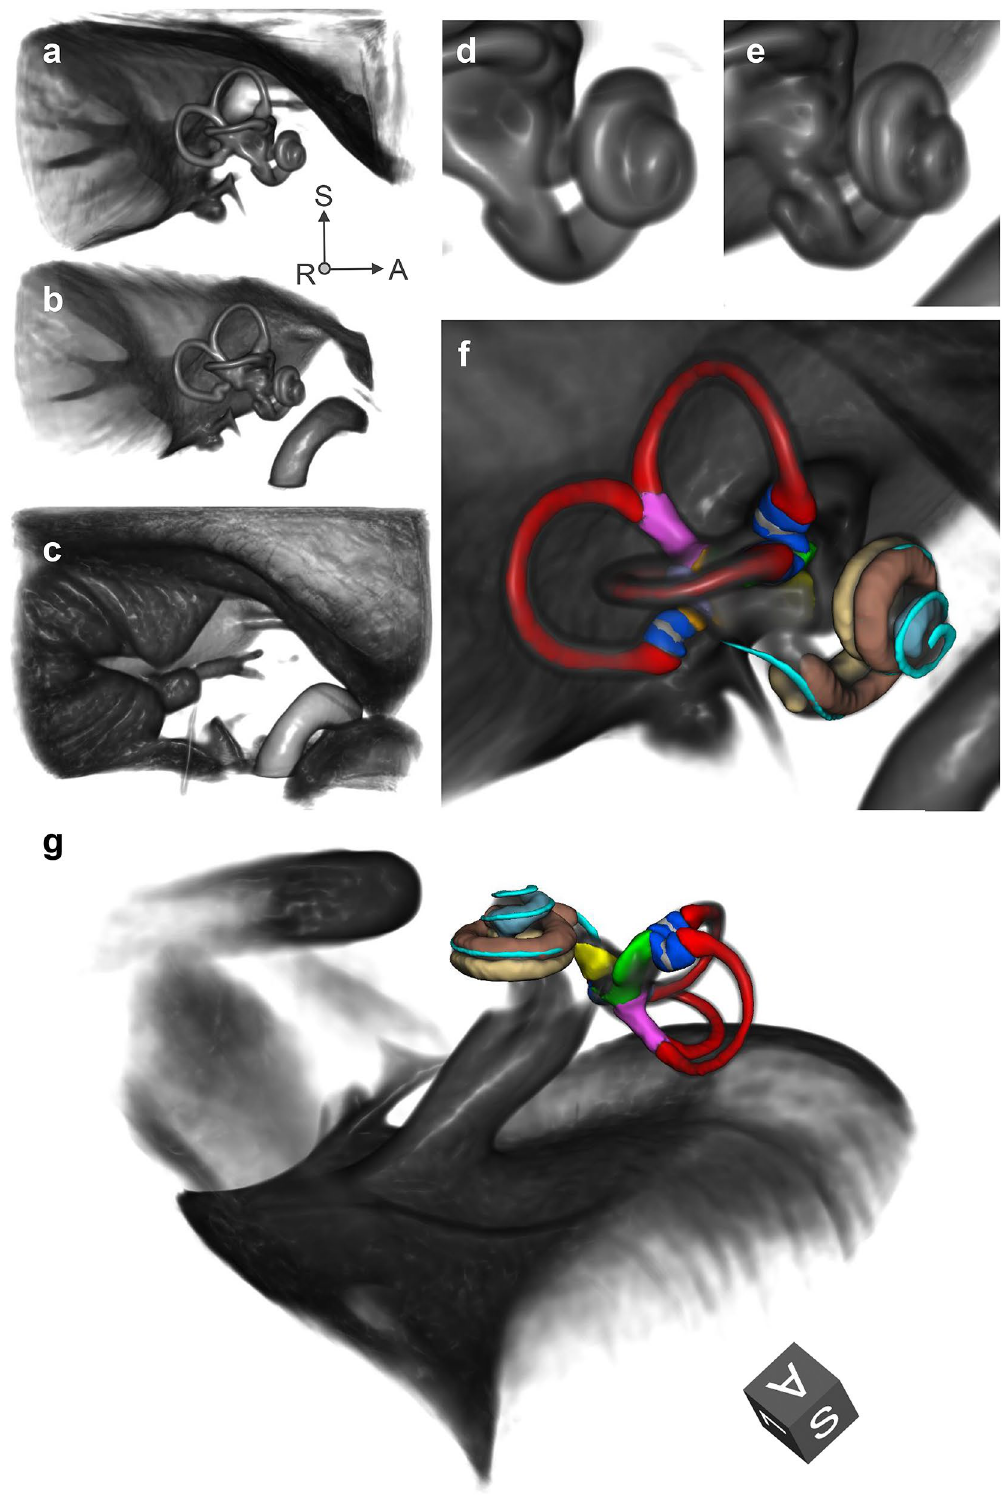
Figure 1. Volume renderings of inner ear templates and atlas. ROI size: 4 × 4 × 3 cm; resolution: 0.2 mm isotropic; viewpoint: right-lateral view onto right inner ear. Panels: ( a ) T2 template; ( b ) CISS template; ( c ) T1 template; ( d ) Closeup of cochlea in T2 template; ( e ) Closeup of cochlea in CISS template, with a clear separation of scala tympani and vestibuli; ( f ) Atlas surface meshes on CISS template volume rendering. ( g ) Same as ( f ), with a different perspective focussing on the vestibule. Colours and regions: red: semicircular canals; blue: ampullae; pink: common crus; grey: cupula walls; green: utricle; yellow: saccule; brown: scala vestibuli; beige: scala tympani; light blue: cochlear cupula; cyan: cochlear duct. The coordinate system arrows (panels a – f ) and cube (panel g ) indicate the anterior (A), superior (S) and left/right (L/R) directions. (Figure panels created with 3D Slicer, v4.11 (https ://www.slice